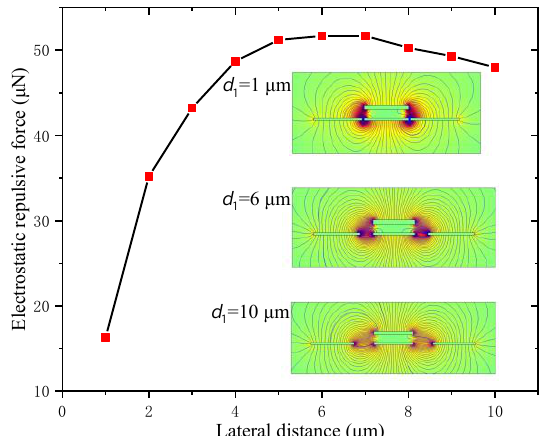
Figure 6. Electrostatic repulsive force versus the lateral distance between two adjacent fixed electrodes ( V = 500 V, d 2 = 4 μm, W m = 20 μm, W f = 22 μm and h m = 2 μm) .